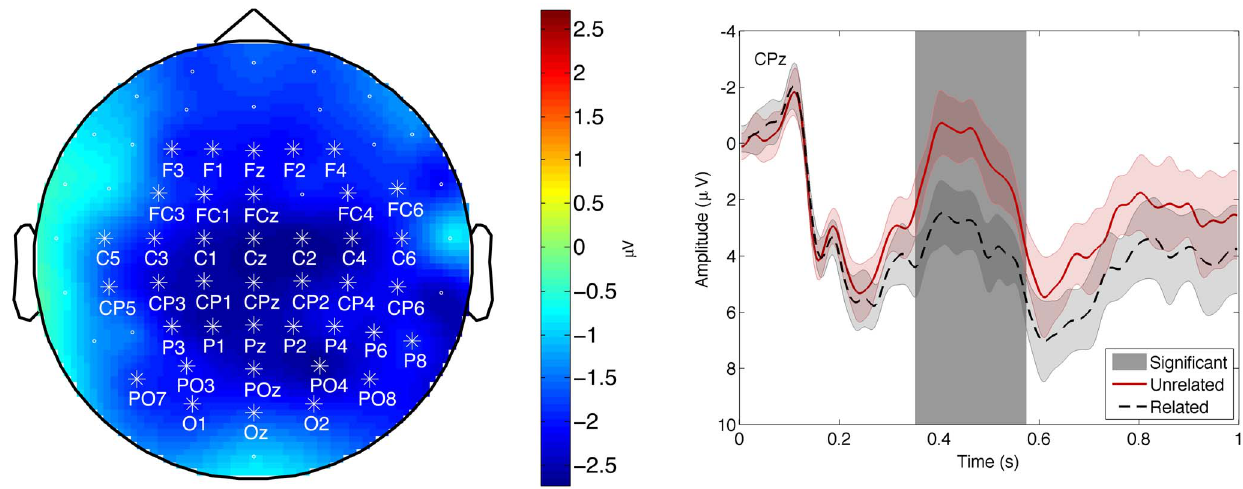
Figure 3. Grand average results for the negative component. Left panel: A topographic representation of the negative component between 330–600 ms. The marked channels show a significant difference between related and unrelated probe responses. Right panel: ERP waveforms for channel Cz for related (black, dashed) and unrelated (red, solid). The area around each line represents the standard deviation, corrected for a within subject design ([37], p. 361–366). Channel Cz has been chosen as an example channel, as other significant channels are similar. Areas marked in grey show a significant difference.